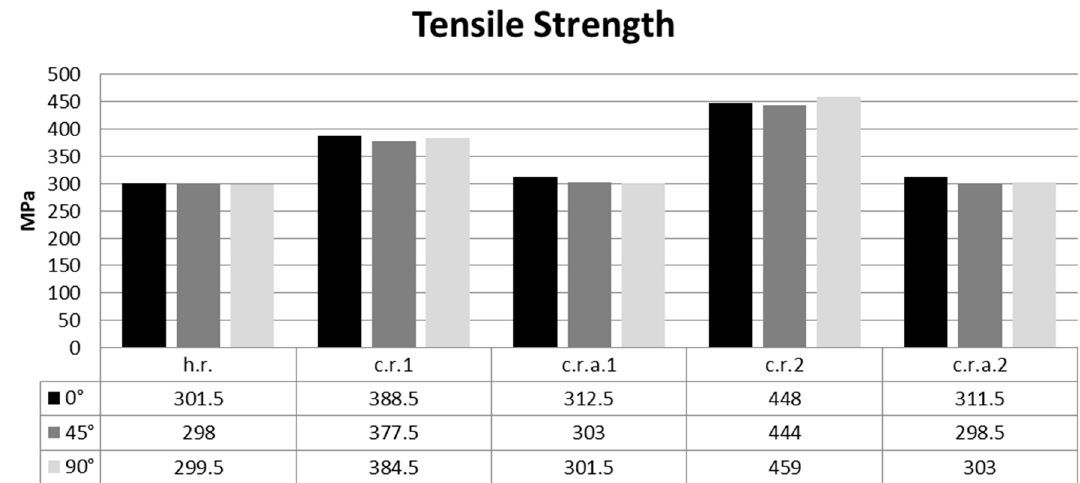
Figure 7. Tensile strength data for all products and conditions.